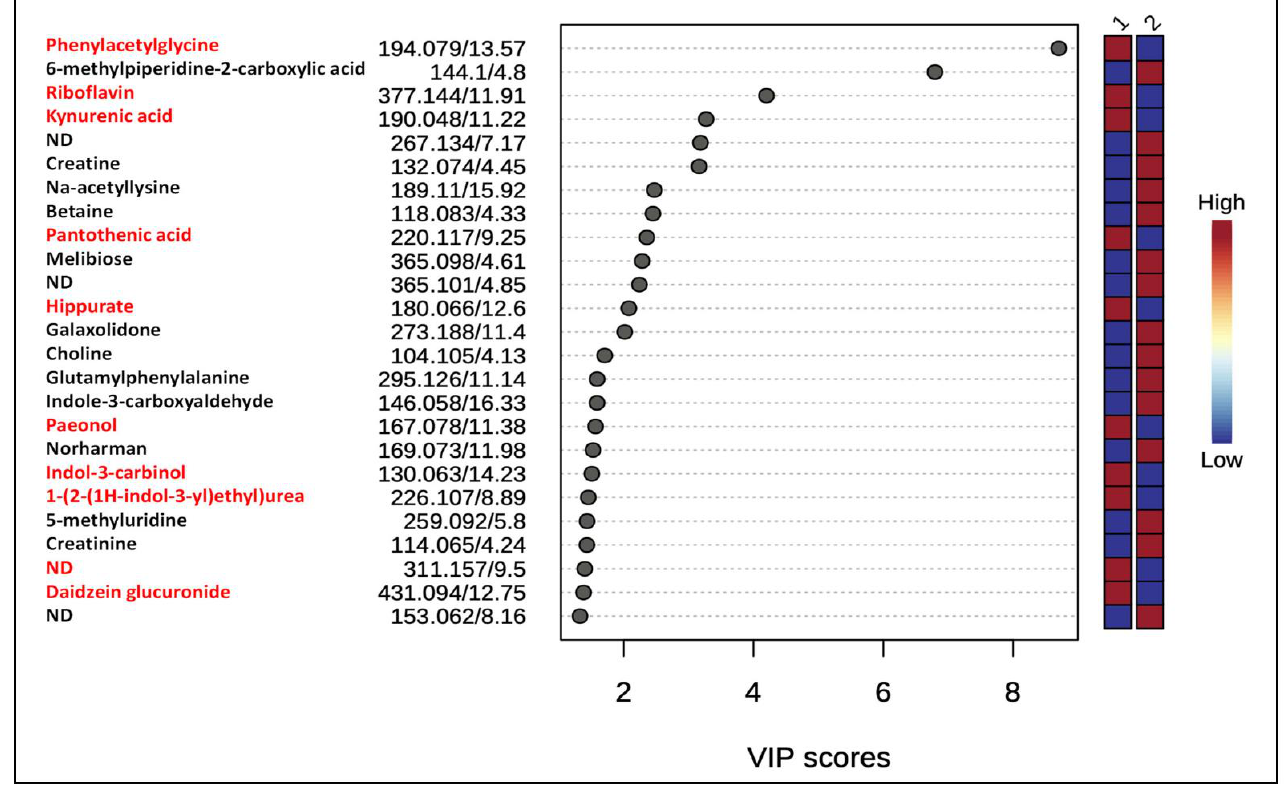
Figure 3. Variable Importance of Projection (VIP) scores for the 25 most contributing features from PLS − DA in positive ion modes. Colored boxes on the right panel indicate the relative intensity of the corresponding feature in each group. ND = not determined. 1 = gID − fed animals, 2 = non − gID-fed animals. Metabolites highlighted in red indicate their higher levels in animals fed with gID.